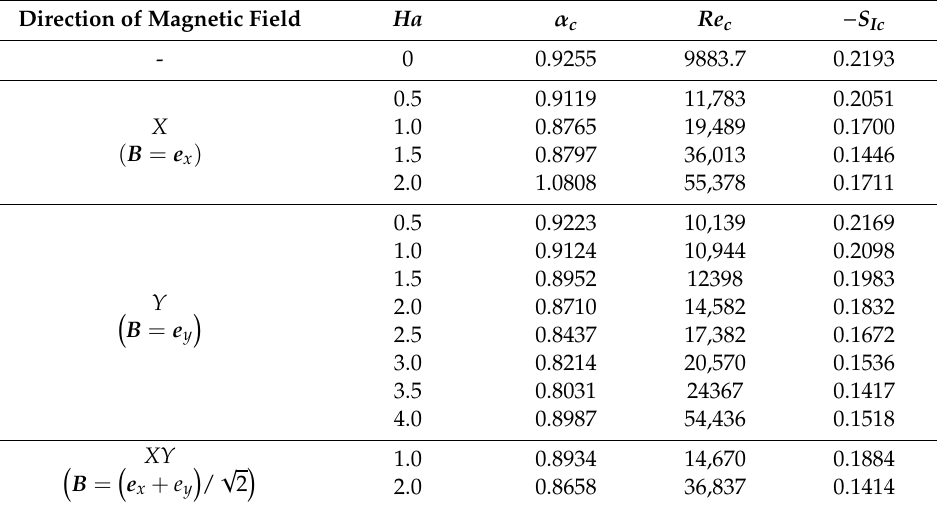
Table 3. E ff ect of the direction of the uniform magnetic field on the critical values obtained for various values of Hartmann number at A = 5. The number of meshes employed within the cross-section is 50 × 250 in the X - and the Y -directions,